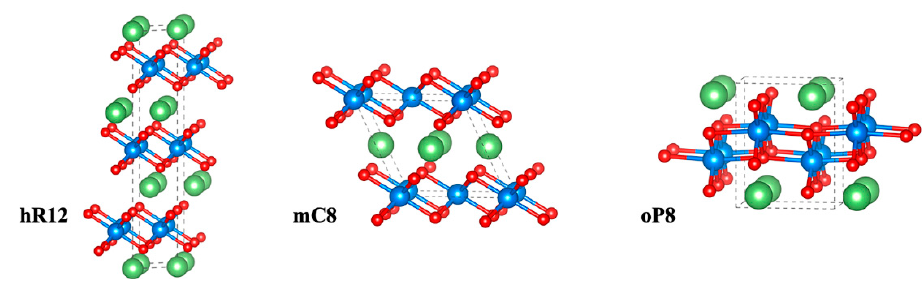
Figure 1. LMO unit cells of rhombohedral (hR12), monoclinic (mC8) and orthorhombic (oP8) structures. Color code: Li green, Co, Ni and Mn light blue and oP8 red.